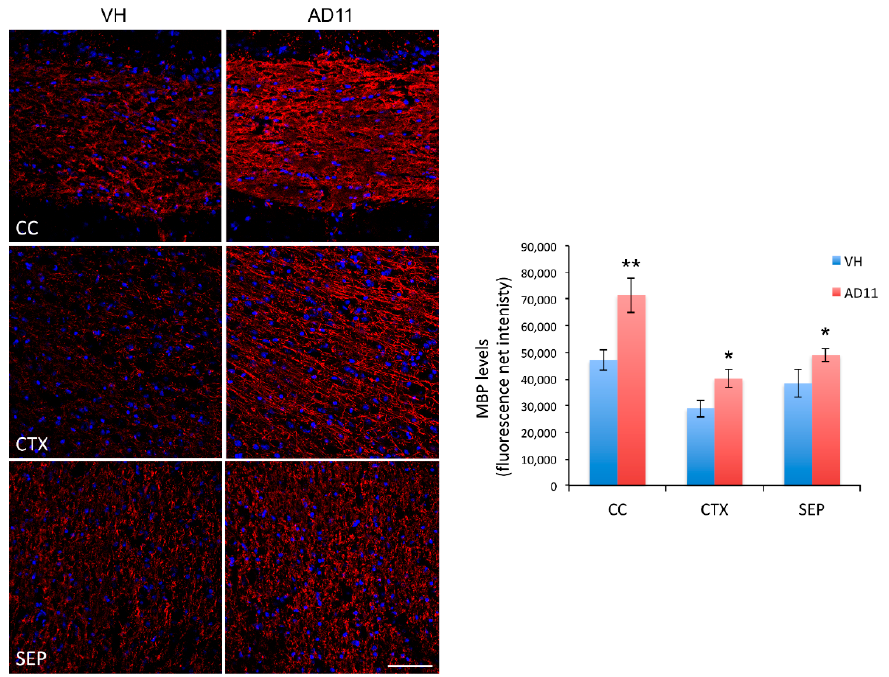
Figure 1. NGF neutralization increases myelination in vivo. Anti-myelin basic protein (MBP) im- munostaining (in red) is higher in AD11 brain areas such as the corpus callosum (CC), the cerebral cortex (CTX), and the septum (SEP), as compared to control animals (VH). The histogram reports the quantification of the net fluorescence intensity in these areas. Nuclei labeled with 4,6-diamidine- 2-phenylindole dihydrochloride (DAPI) are in blue. Scale bar 75 µm; magnification 40×. The results are expressed as the mean ± standard error (SEM) from three animals for each geno- type (quantifying six slices per animal). Statistical significance is calculated relative to the VH sam- ple for each area. Student’s t -test: * p < 0.05, ** p < 0.01.